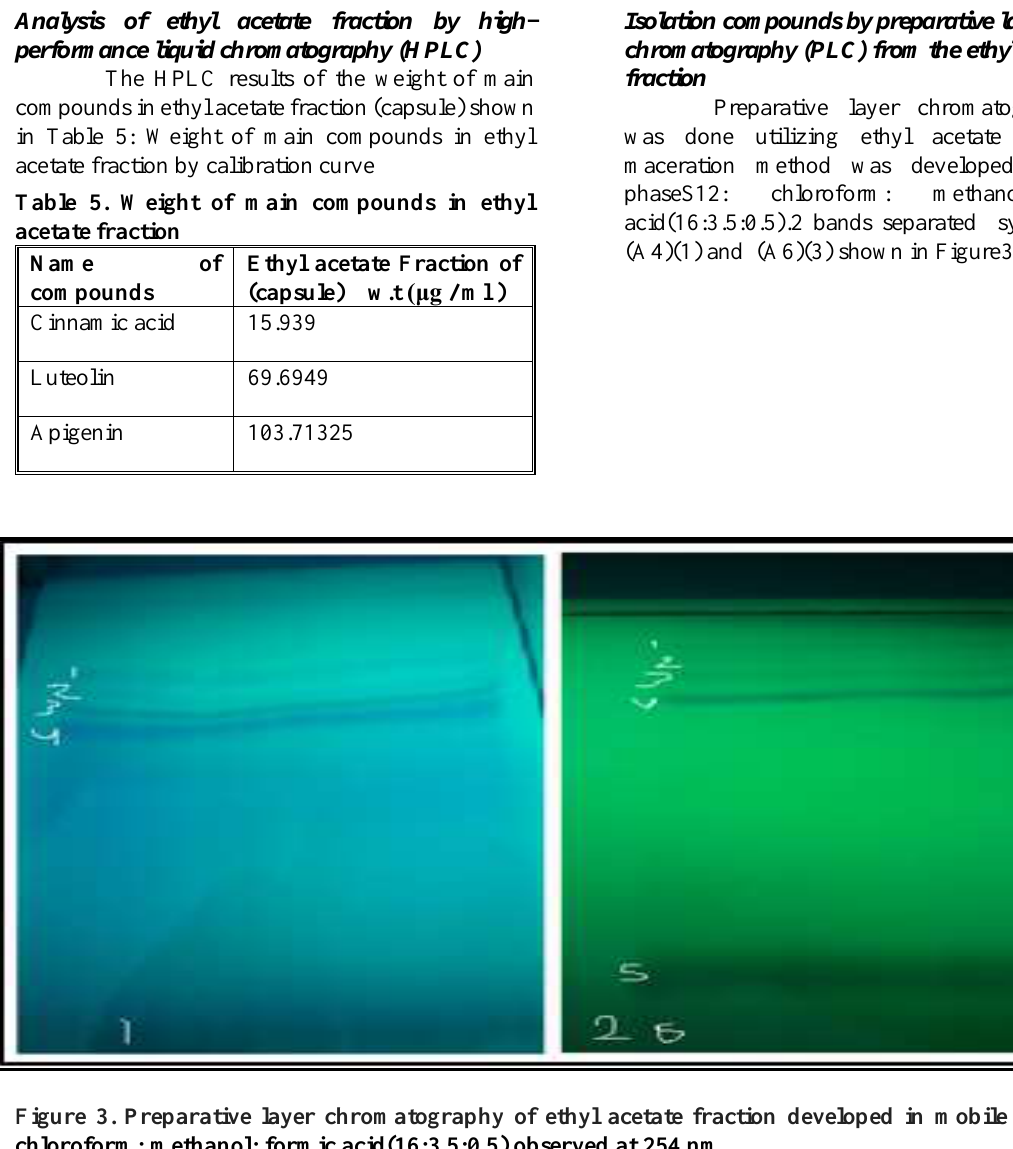
Figure 3. Preparative layer chromatography of ethyl acetate fraction developed in mobile phase (S12) chloroform: methanol: formic acid(16:3.5:0.5) observed at 254 nm. HPTLC for isolated compounds A4(1) and A6(3) isolated by (PLC)and A1 isolated by (HPLC) and standards .